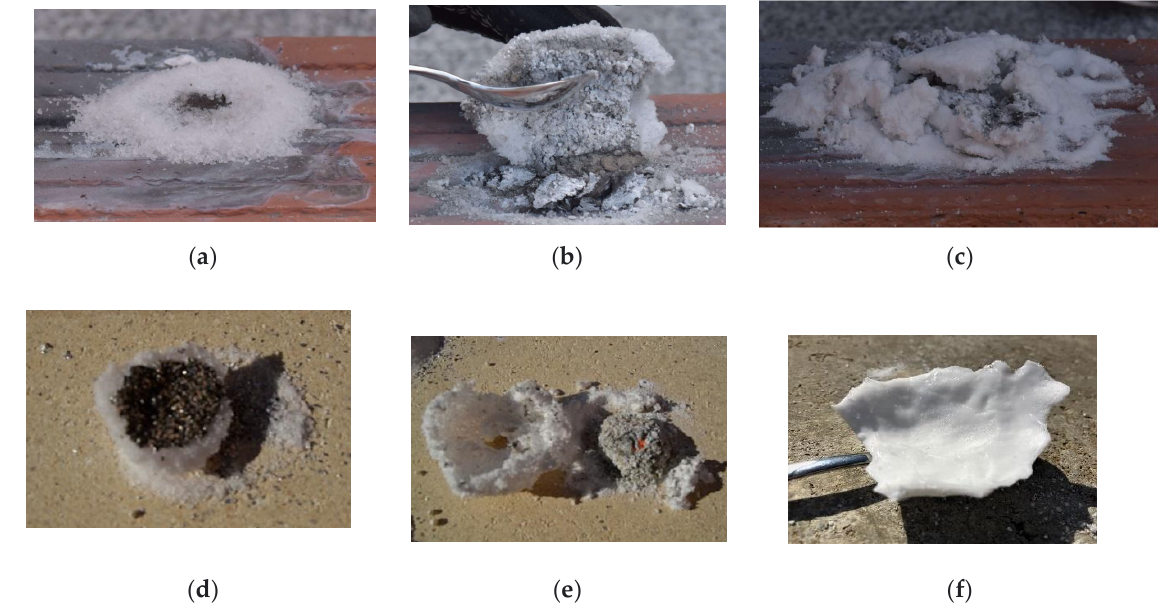
Figure 4. Extinguishing agent (20 g) shed onto 2 g of burning Mg flakes. From top left to bottom right: ( a ) NaCl gives no crust; ( b ) KCl yields a stable crust; ( c ) sodium borate leaves behind a brittle crust; ( d ) MgSO 4 gives a brittle crust. ( e ) Brittle crust from NaCl and boric acid (50/50 by weight); ( f ) Boric acid, stable crust.